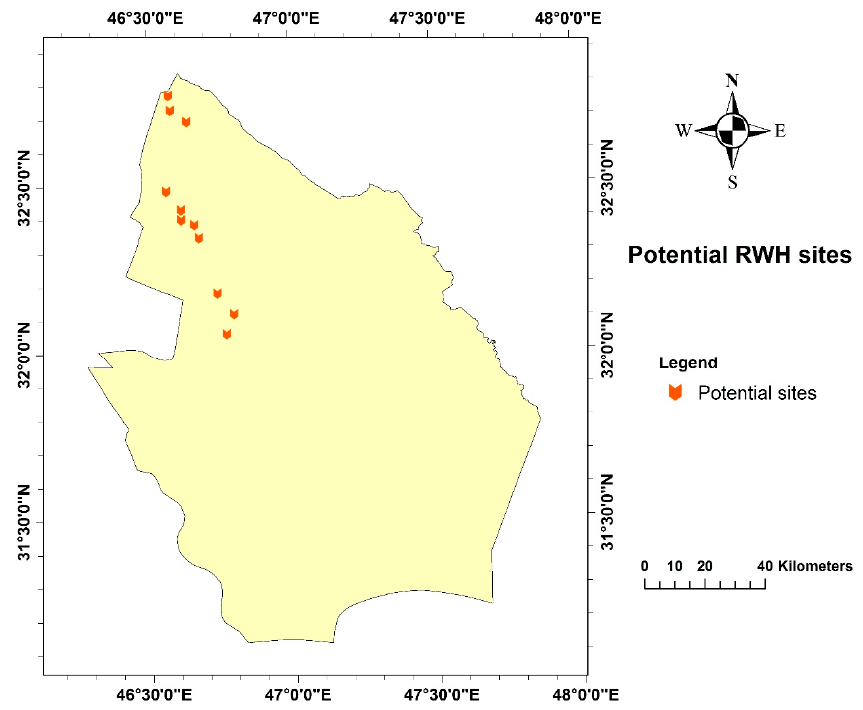
Figure 13. Potential rainwater harvesting sites. Table 2. Proposed RWH sites coordinates.